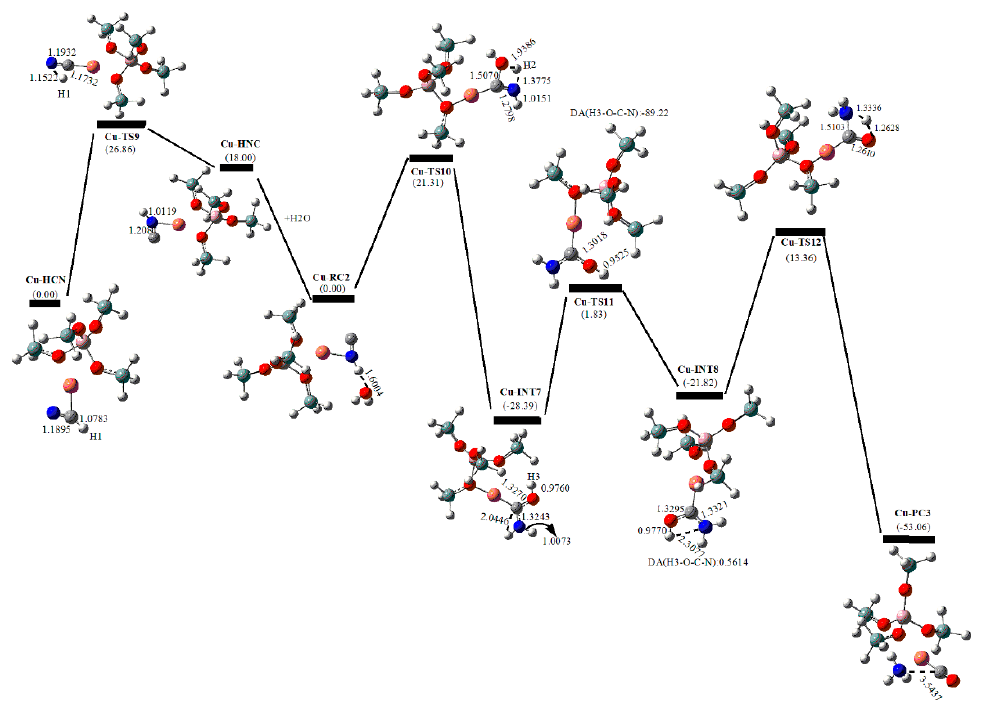
Figure 6. B3LYP/6-31++G (d,p)-optimized structures (in Å) of the stationary points of hydrolysis of HCN with Cu-ZSM5 in the gas phase for path C. The values correspond to the relative free energy ( ∆ G) in kcal/mol with respect to the separate reactants.